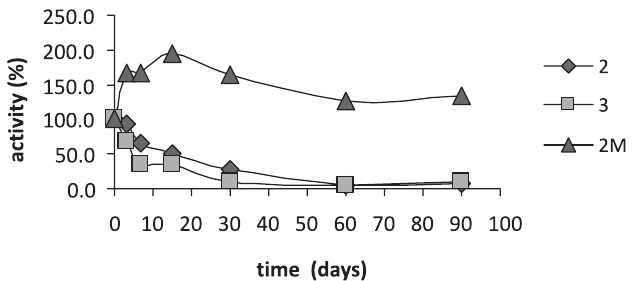
FIGURE 3 - Papain activity variation (%) for formulations 2, 3, 2M and Gel at 40 ± 2.0 ° C during the Normal Stability